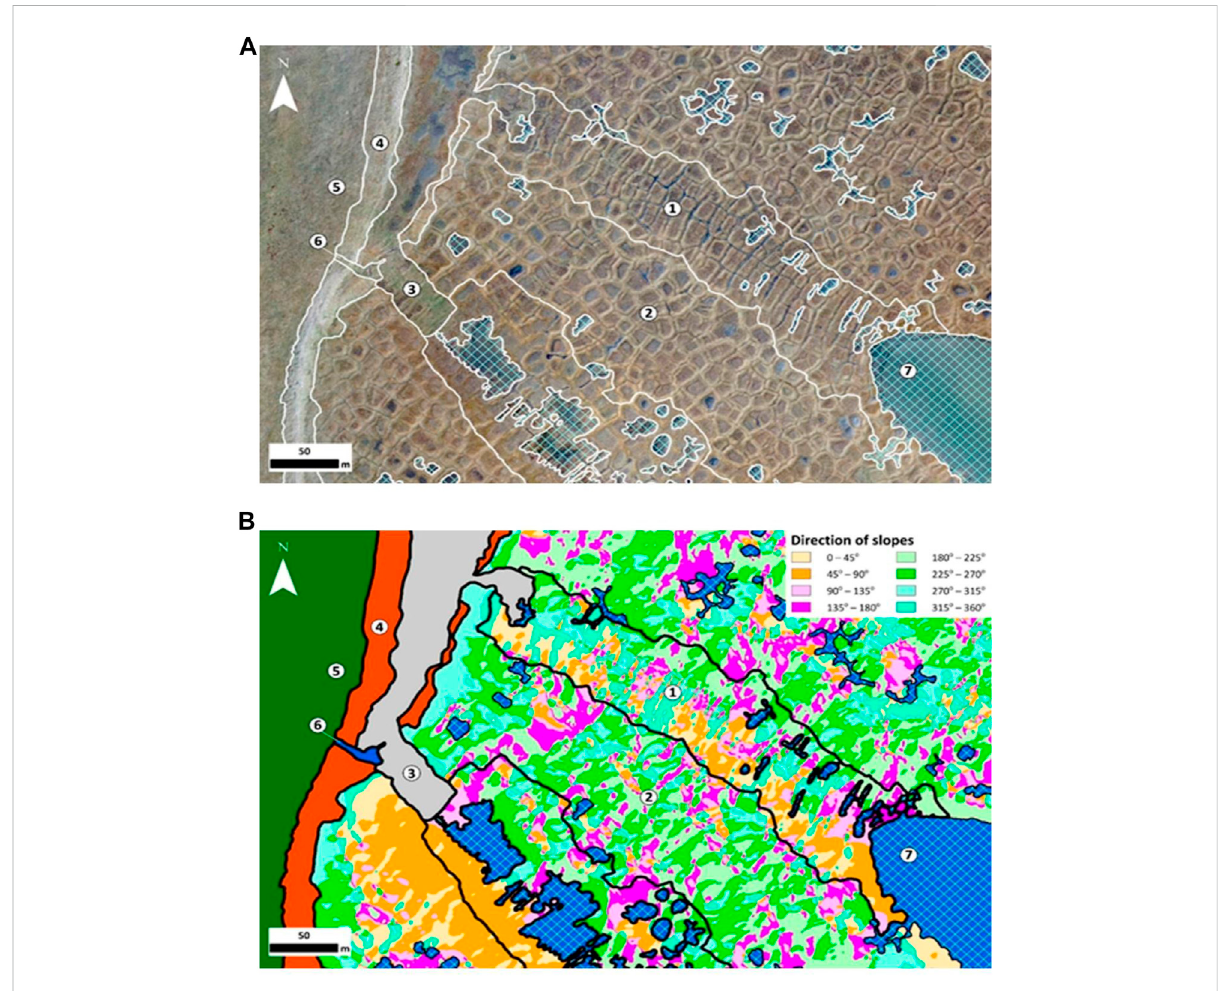
FIGURE 5 Elongated terrains of drainage valleys in the Samoylov Island central part on an orthophoto map that is mixed with a GSR map (A) and on an aspect map (B) . Legend: 1 — drainage valleys; 2 — both types of polygons; 3 — fl ooded terrains; 4 — slopes; 5 — fl oodplain; 6 — brooks. Colors 1 and 2 on (B) signify the slopes ’